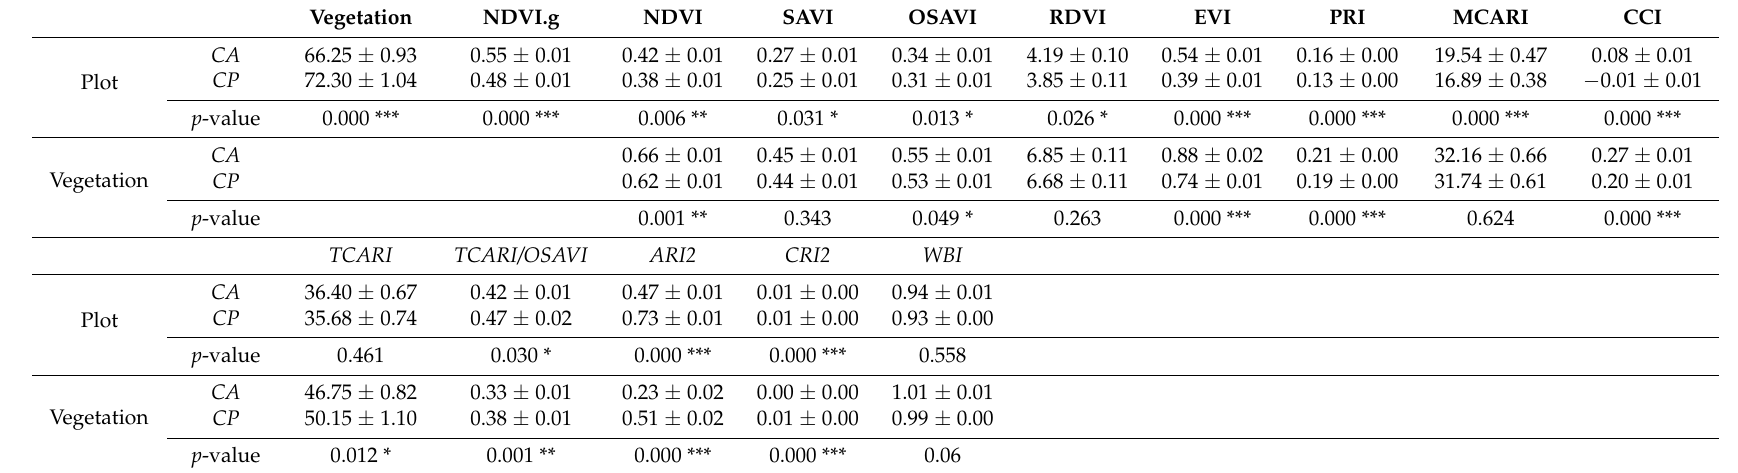
Table 5. Effect of tillage practices (CA versus CP) and the application of the soil mask (plot measurements versus vegetation measurements) on the multispectral indexes. These indexes are defined in Materials and Methods. Values are means ± standard error. Level of significance ( p -value): *, p < 0.05; **, p < 0.01; ***, p < 0.001. Treatments: CA, conservation agriculture; CP, conventional